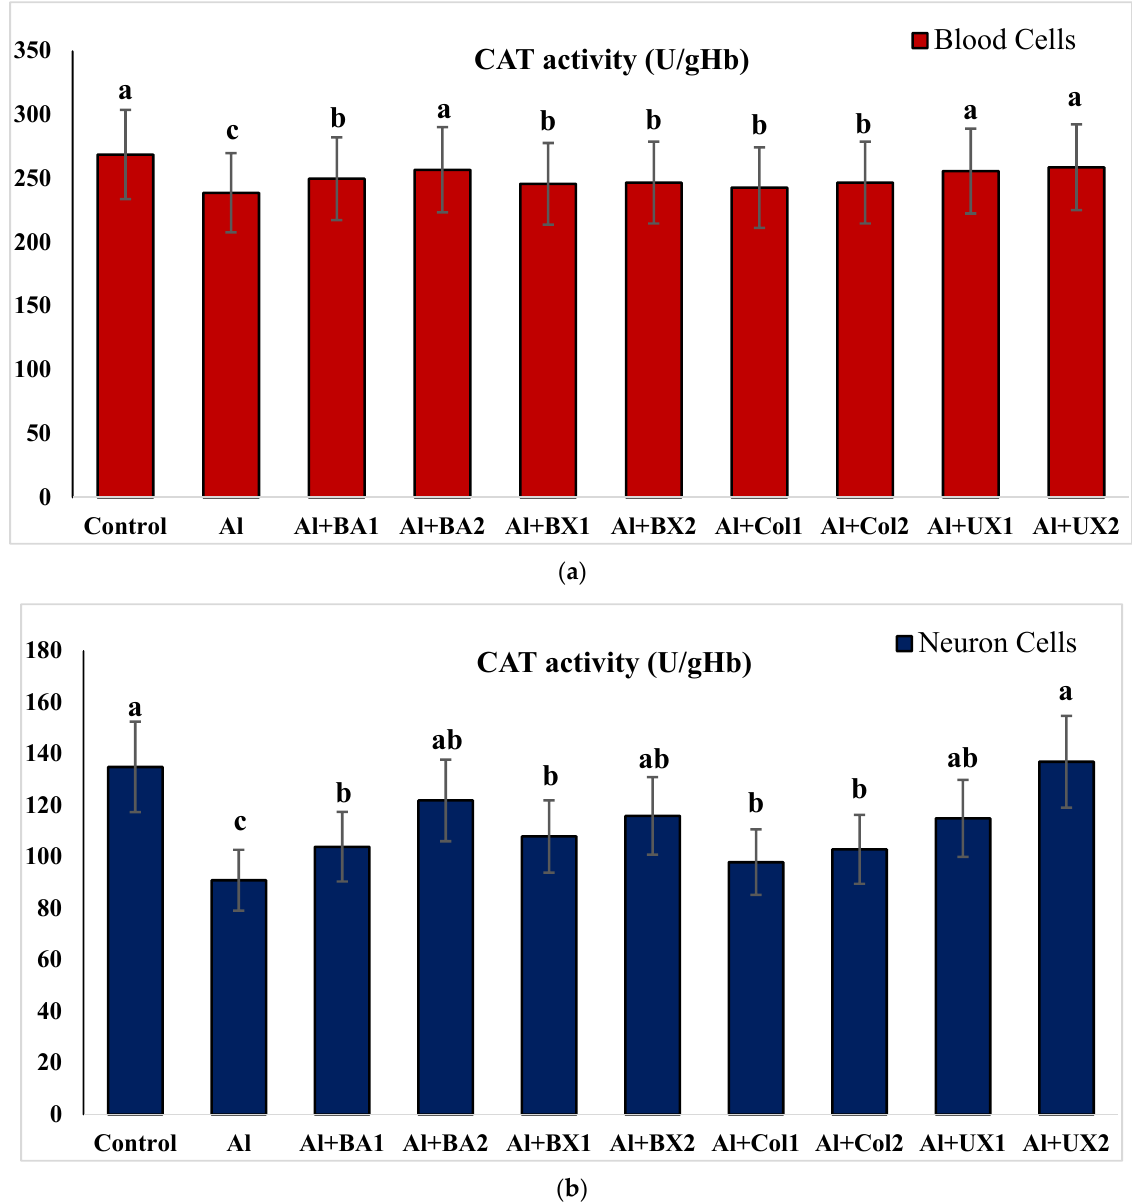
Figure 3. The effect of Al and boron treatments in ( a ) human blood and ( b ) PRCNs on CAT activity. Abbreviations are as in Figure 2. (Each superscript letter (a, b, c) represents statistically similar groups).